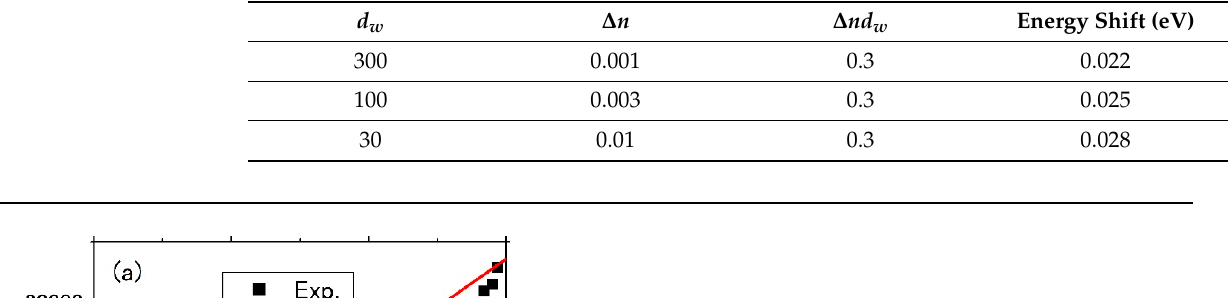
Table 2. The energy shift of the SPP resonance from that with n = 1.330 in Figure 8c.